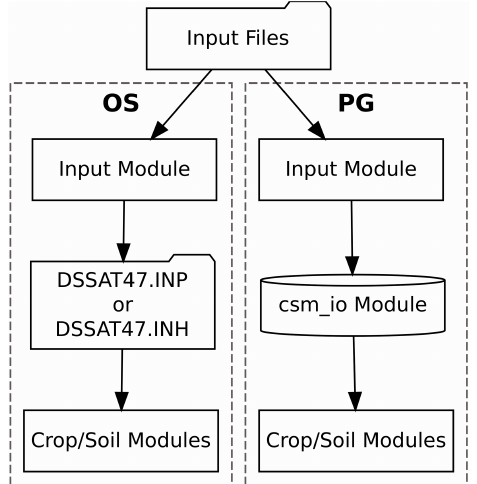
Figure 1. Flowchart illustrating the data transfer processes imple- mented in the standard open-source (OS) and parallel gridded (PG) versions of the Decision Support System for Agrotechnology Trans- fer Cropping Systems Model. The folder shape indicates a step that involves reading or writing a file. The cylinder shape indicates an in-memory data